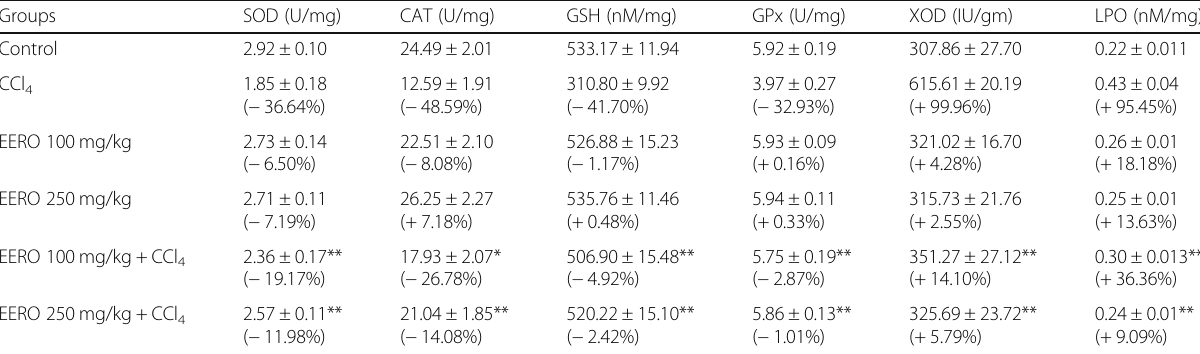
Table 2 Effect of ethanolic extract of Rosmarinus officinalis (EERO) on, SOD, CAT, GSH, GPx, LPO, and XOD in CCl 4 -induced nephrotoxicity in